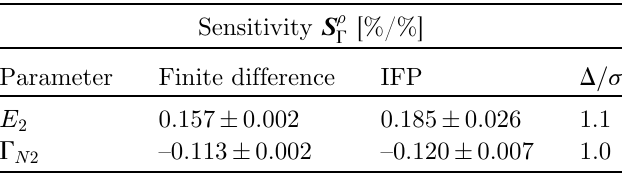
Table 3. Sensitivities to the second 16 O positive-energy resonance parameters for the PST001 benchmark, with angular distribution contribution [14].